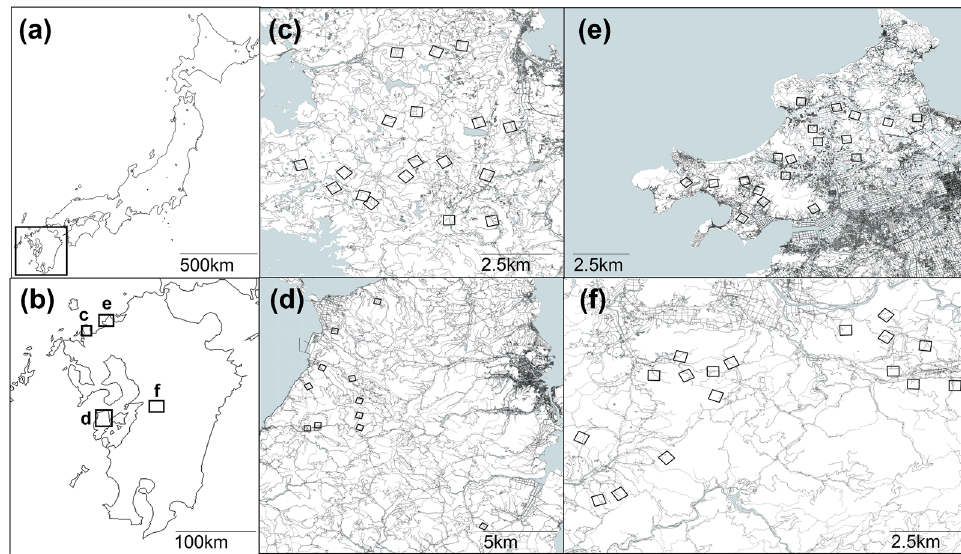
Figure 2. Map of ( a ) Japan and ( b ) the entire study regions, ( c ) Karatsu, ( d ) Amakusa, ( e ) Itoshima and ( f ) Uki. Squares represent study blocks. Light and dark grey areas indicate waterbodies and residential areas, respectively. Background map source is the black map of Japan (http:// www. craft map. box-i. net/ japan/ line. php) and the topographic data of Fundamental Geospatial Data developed by the Geospatial Information Authority of Japan (https:// www. gsi. go. jp/